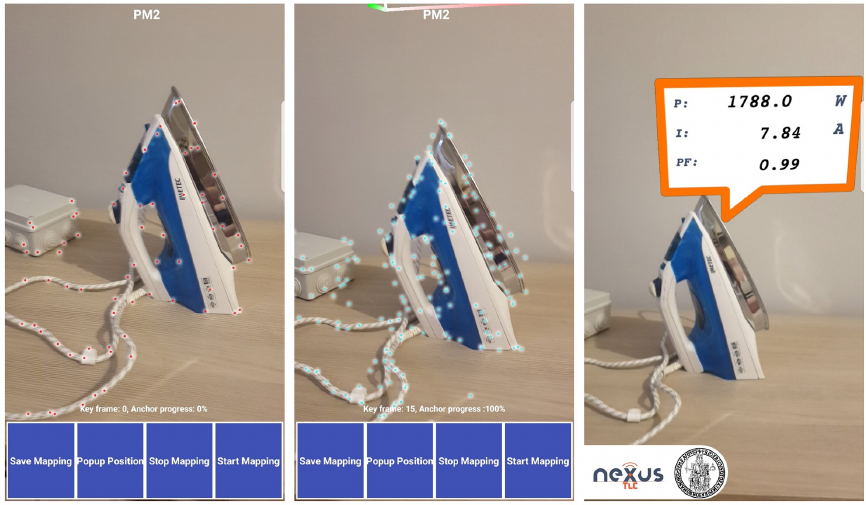
Figure 17. Features extraction and AR data rendering for load associated with 00AEF1CA1212/PM2 .